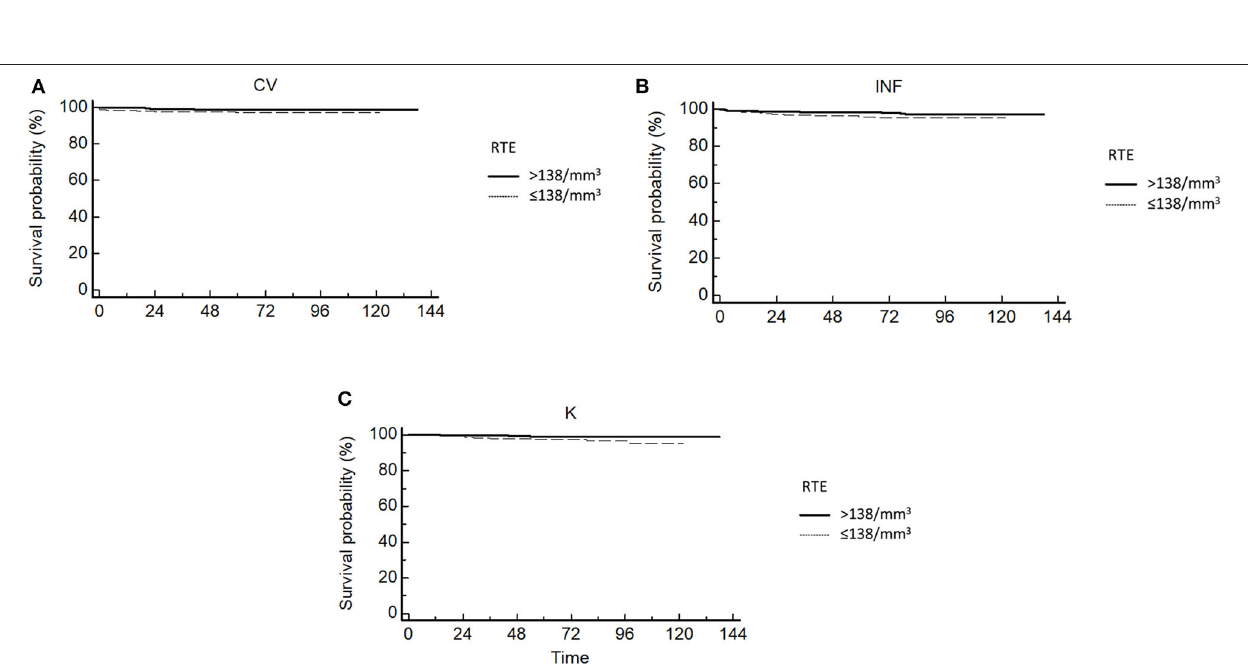
FIGURE 1 | Kaplan-Meier death in transplantation-free survival curves for patients according to quartiles o RTE. Ranges of RTE: Q1 [2–74], Q2 [75–135], Q3 [136–230], and Q4 [231–1,135].